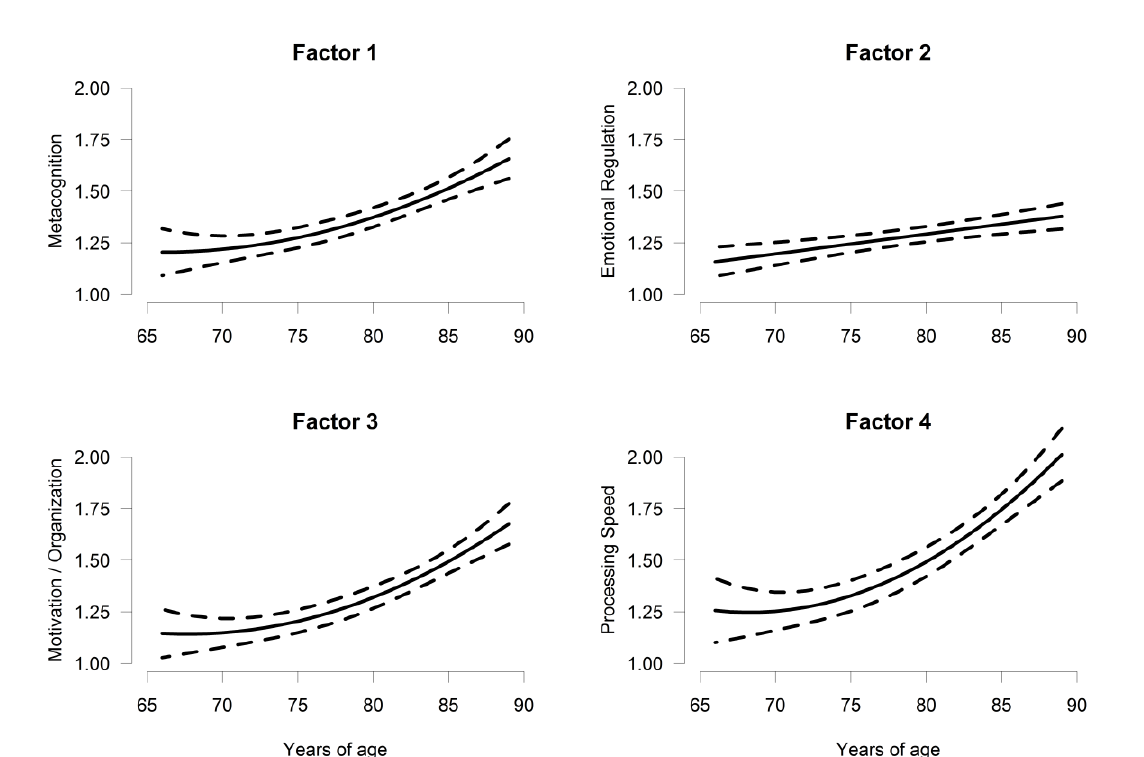
Figure 2. Estimated effects of age and their 95% confidence interval on Factors 1 – 4 scores.